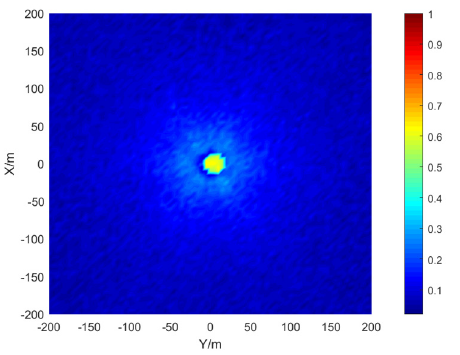
Figure 17. Positioning accuracy of stereo array 3 under combination algorithm.